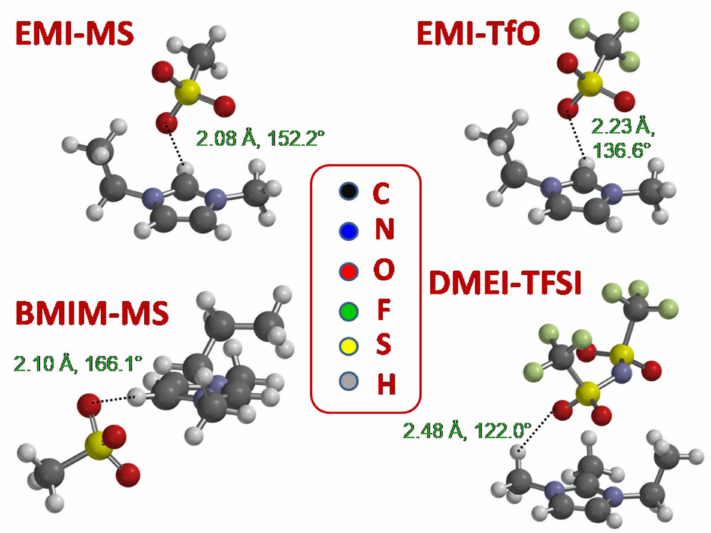
Figure 2. Lowest energy ionic couples composing the four ionic liquids, calculated by DFT using the ω B97X-D functional and considering the presence of a polar solvent ( ε r = 37.22); in all cases the 6-31G** basis set was employed. The dotted lines show the closest H-O bonds for each. For DMEI-TFSI, the lowest energy configuration of the ion pair involves the TFSI anion in its trans-configuration, which is known to be more stable than the cis-configuration [41].